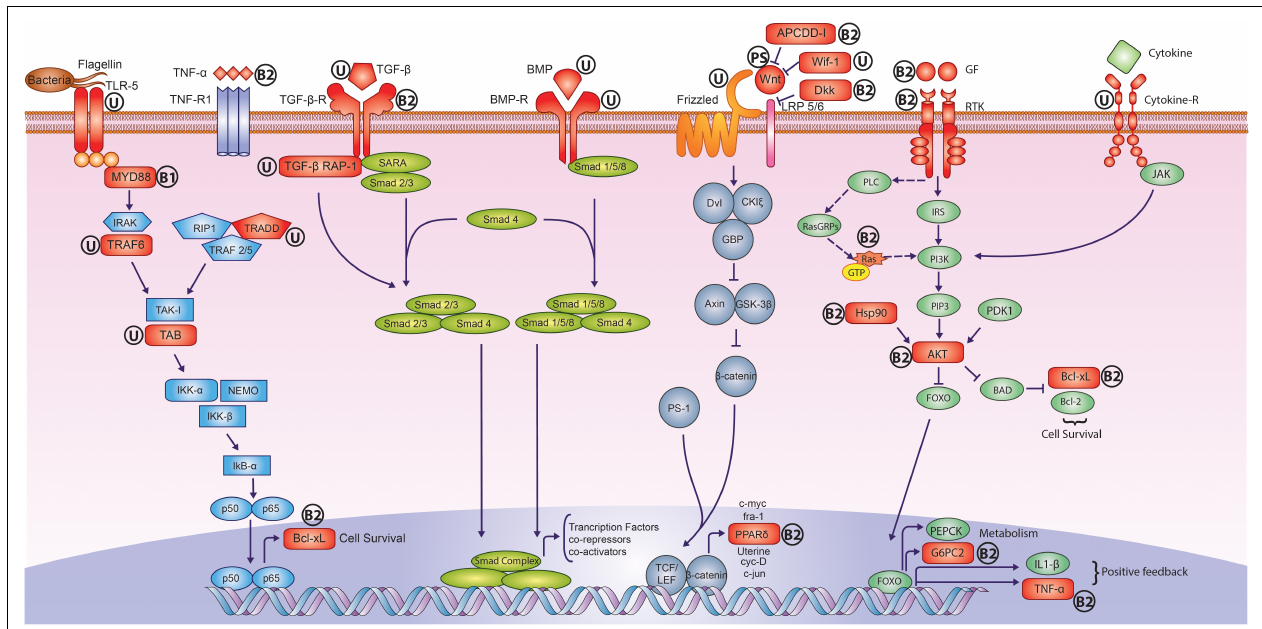
FIGURE 4 | Adaptively evolved signaling pathways in peacock genome. The genes highlighted in Red color showed signs of adaptive evolution such as positive selection and unique substitution. The symbol “U” stands for only unique substitution(s), the symbol “PS” stands for only positive selection, the symbol “B1” stands for unique substitution(s) and also harbors the positively selected amino acid residues but overall genes do not show any positive selection, and the symbol “B2” stands for unique substitution(s) and positive selection. It is apparent that the receptors, ligands and regulators of early development pathways such as Wnt, TGF- β , and BMP, showed adaptive sequence divergence in peacock. In the case of NF- κ B, cytokine and growth factor signaling pathways, the proteins involved in intermediate signal transduction also showed adaptive sequence divergence. Individual pathways are color coded